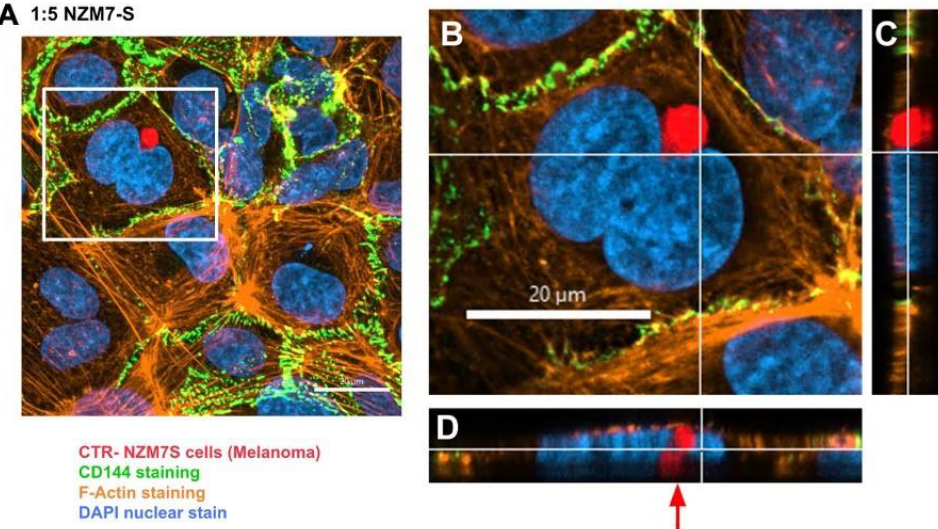
Figure 14. Confocal microscopy Z-stack image of NZM7-S position localised to the hCMVEC nucleus. hCMVECs were seeded at 20,000 cells per well. NZM7-S were live stained with CytoTrack Red (CTR) and applied to the apical face of a confluent endothelial monolayer. Samples were analysed by confocal laser scanning microscopy. ( A ) The xy-stack of NZM7-S added at an E:T ratio of 1:5. ( B ) The xy-stack at the level of the white lines on ( C , D ). ( C , D ) The z-stacks along the vertical and horizontal line, respectively, on ( B ). ( A ) The NZM7-S positioned within the endothelial cell body next to the hCMVEC nucleus. Red arrow indicates interesting finding of NZM7-S close to the nucleus. Images acquired using a Zeiss LSM 800 Airyscan confocal microscope.